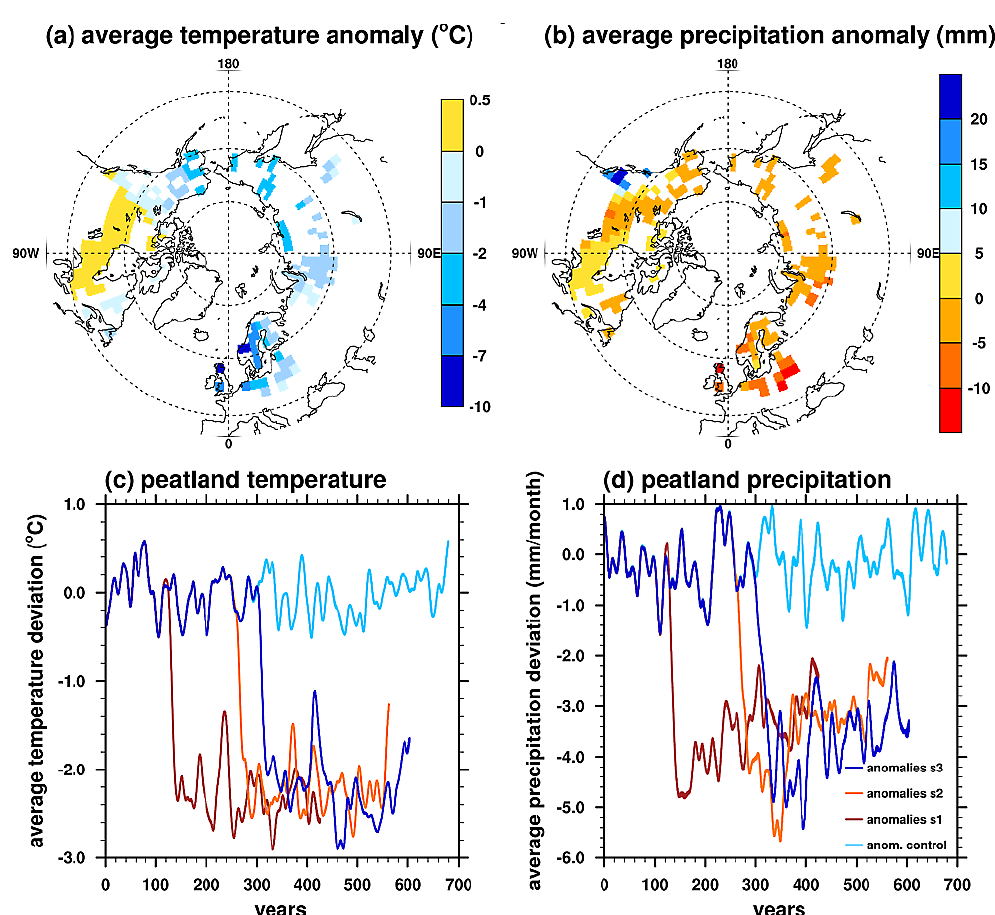
Fig. 5. Temperature and precipitation anomalies in boreal peatlands simulated by NCAR CSM 1.4 in response to freshwater hosing in the North Atlantic. Top: anomalies represent the differences in 50yr averages of monthly data before and after the freshwater release of ensemble run 1. Bottom: anomalies represent spatial-averages using peatland area of each grid cell as weights and with respect to the mean of the control simulation (2 months running